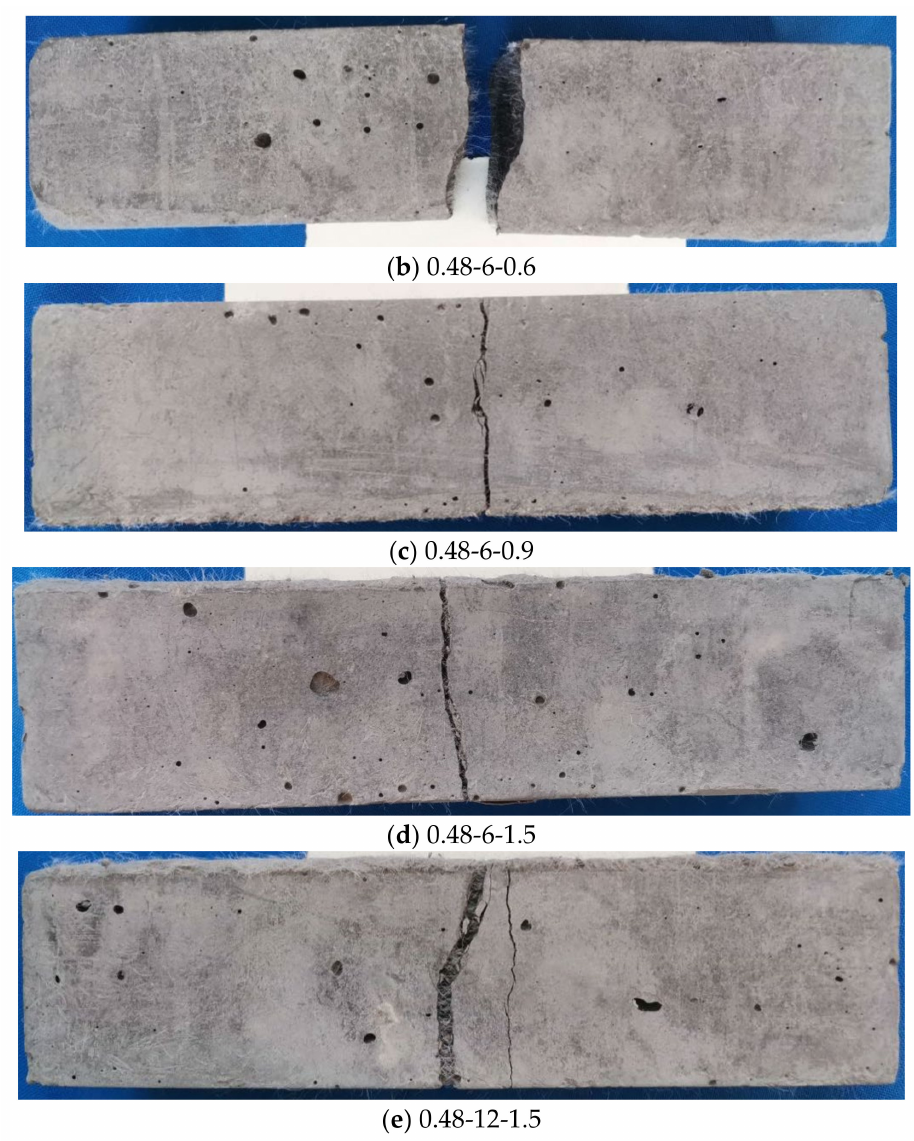
Figure 16. Typical cracking morphologies of PP fiber-reinforced geopolymer